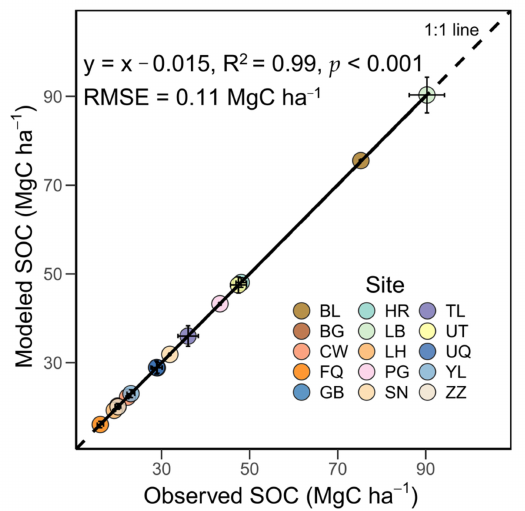
Figure 3. The performance of the RothC model. The site- and treatment-specific model parameters constrained against the observations were used. R 2 is the coefficient of determination, p shows the associated significance level, and RMSE is the rooted mean squared error. Solid and dashed lines show the linear regression and 1:1 line, respectively. A dot with error bars shows the mean and standard deviations of data for a given site. BL: Bad Lauchstädt; BG: Bologna; CW: Changwu; FQ: Fengqiu; GB: Gibson; HR: Harbin; LB: Lethbridge; LH: Ludhiana; PG: Prague; SN: Suining; TL: Tarlee; UT: Ultuna; UQ: Urumqi; YL: Yangling; ZZ: Zhengzhou.